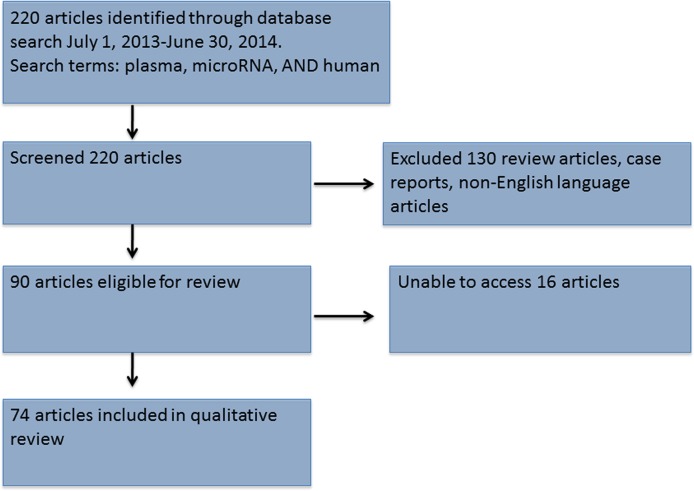
A PRISMA flow diagram illustrating the search strategy used[98].